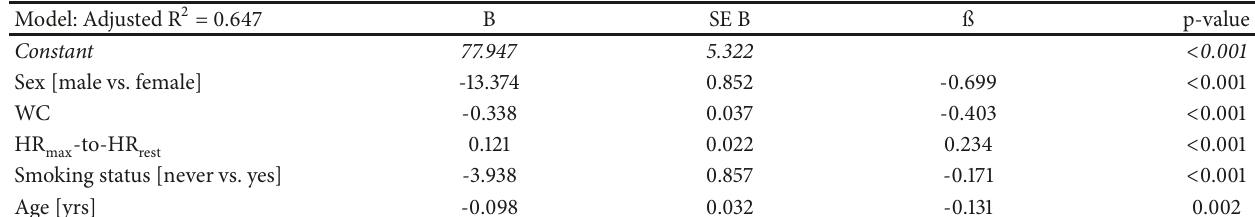
Table 2: Forward-stepwise multiple linear regression analysis with VO 2 max as dependent